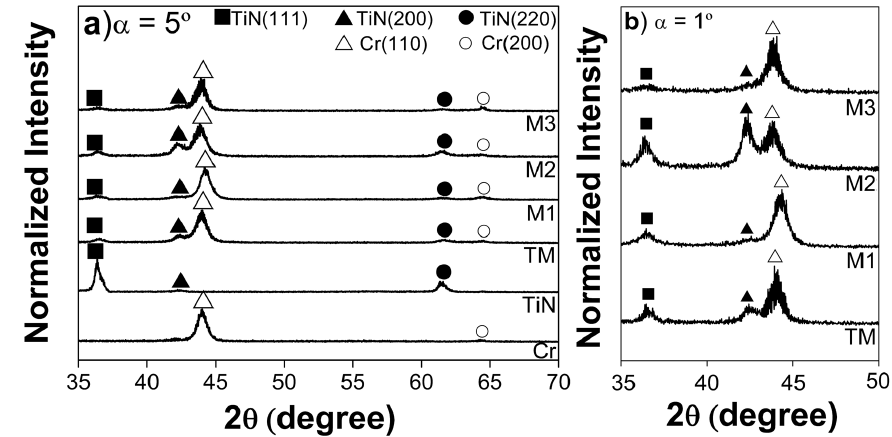
Figure 5. GAXRD patterns of as deposited coatings acquired with incidence angle of (a) 5º and (b)